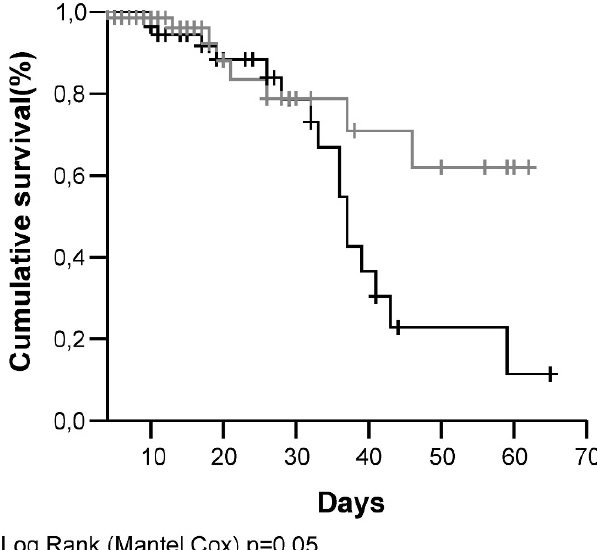
Figure 5 - Kaplan-Meier estimated curves for cumulative survival in the ICU. The black line represents the control group; the gray line represents the intervention group. Tick marks represent censoring. The log-rank (Mantel-Cox) test was used to compare the curves; p=0.05.